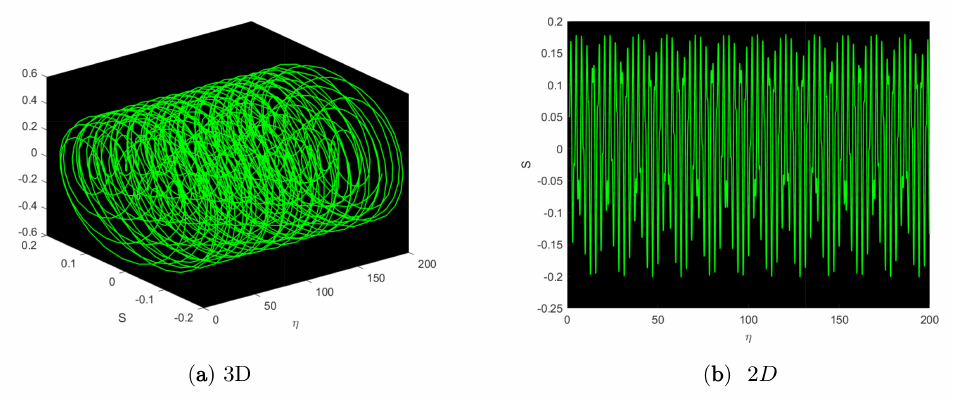
Figure 17. Phase portrait with perturbation term having a 1 = − 4, a 2 = − 4, a 3 = 4, n 0 = 0.92, and f = 4.4 for the dynamical